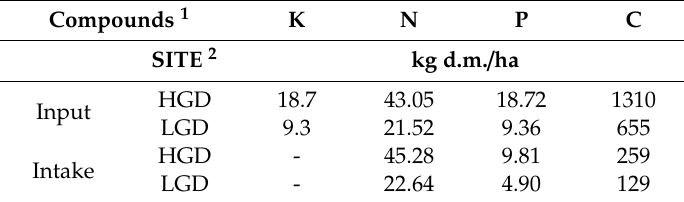
Table 2. Calculated amount (kg d.m. / ha) of N, P, and C added to soil with the geese droppings (Input) and take out by the herbage grazing (Intake) during the rearing period (120 days).